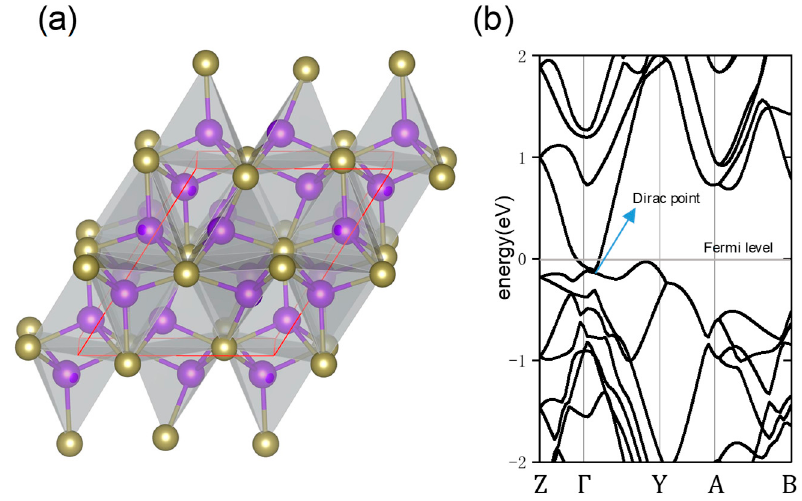
Figure 1. Electronic structure of Ag 2 Te. ( a ) Crystal structure of Ag 2 Te in the monoclinic phase; the yellow balls represent Ag atoms and the purple balls represent Te atoms. ( b ) Calculated band structure of Ag 2 Te, the Fermi level and Dirac point is marked in the figure.